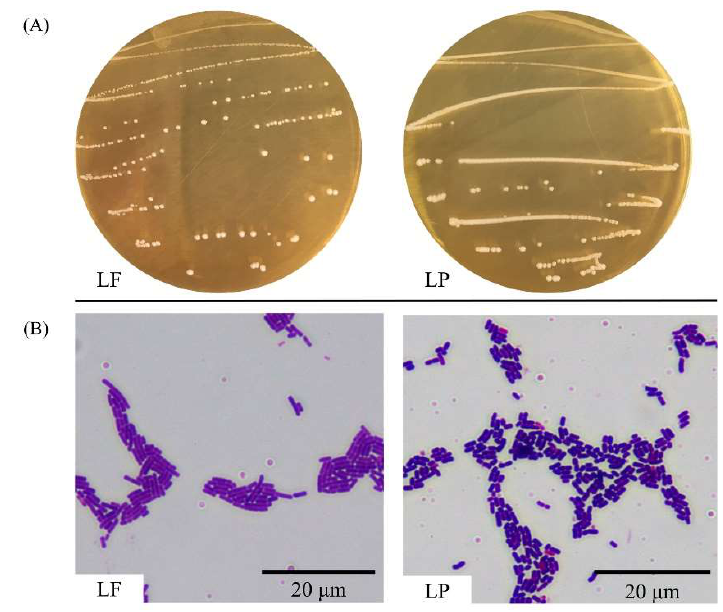
Figure 1. Morphology of strains. ( A ) Colony morphology; ( B ) Cell morphology.